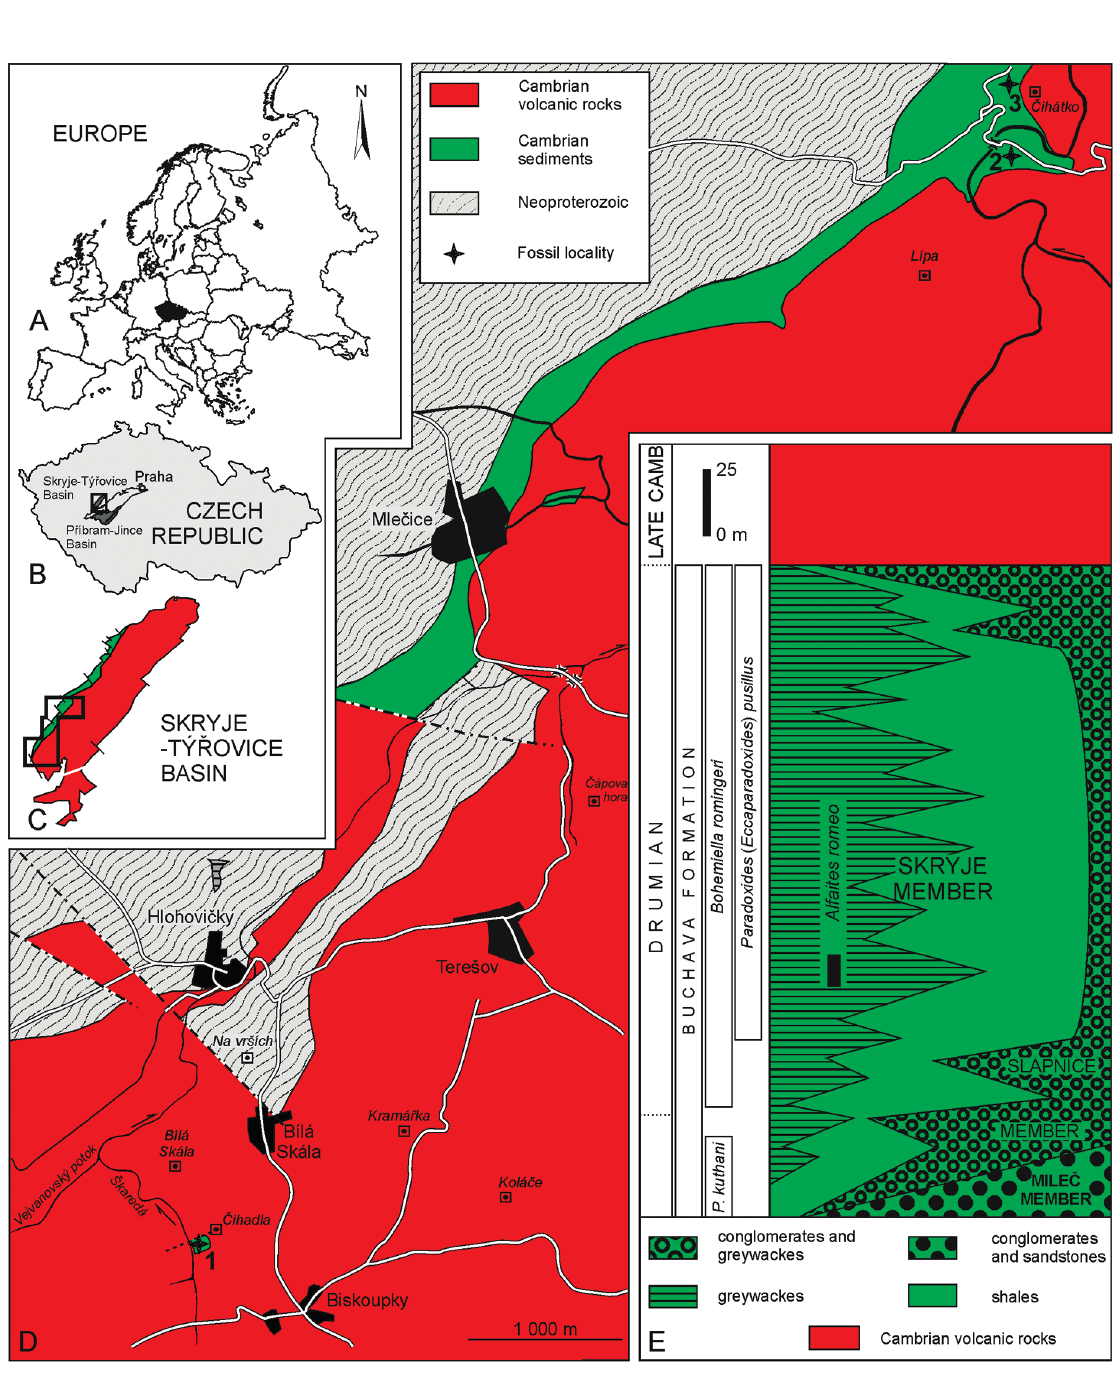
Fig. 1. Maps showing the location of fossil sites in the middle Cambrian Buchava Formation within the Skryje-Týřovice Basin, Central Bohemia. A. Map of Europe with the Czech Republic. B. Map of the Czech Republic showing distribution of Palaeozoic rocks of Barrandian area. C. Simplified sketch map of the Skryje-Týřovice Basin. D. Geological map showing distribution of middle Cambrian Buchava Formation and location of the Buchava, Hradiště and Biskoupky localities. E. Stratigraphic position of the Buchava, Hradiště and Biskoupky localities and range of Alfaites romeo gen. et sp. nov. Geology modified from Mašek et al. (1997) and Vorel et al. (2014); lithostratigraphy and biostratigraphy after Fatka et al. (2011) and Vokáč (2002). 1 = Biskoupky locality; 2 = Buchava locality; 3 = Hradiště